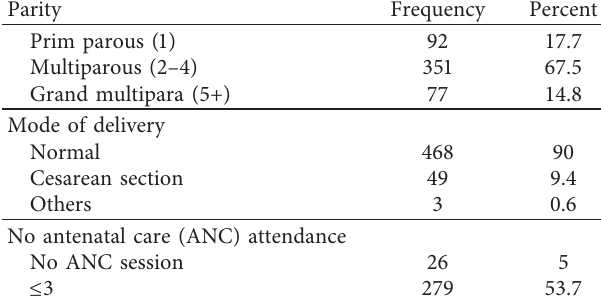
Figure 3: Sources of information about advantages of breast milk feeding in Shashemene city, Oromia, Ethiopia, 2020. TV: television, HCWS: health care workers.